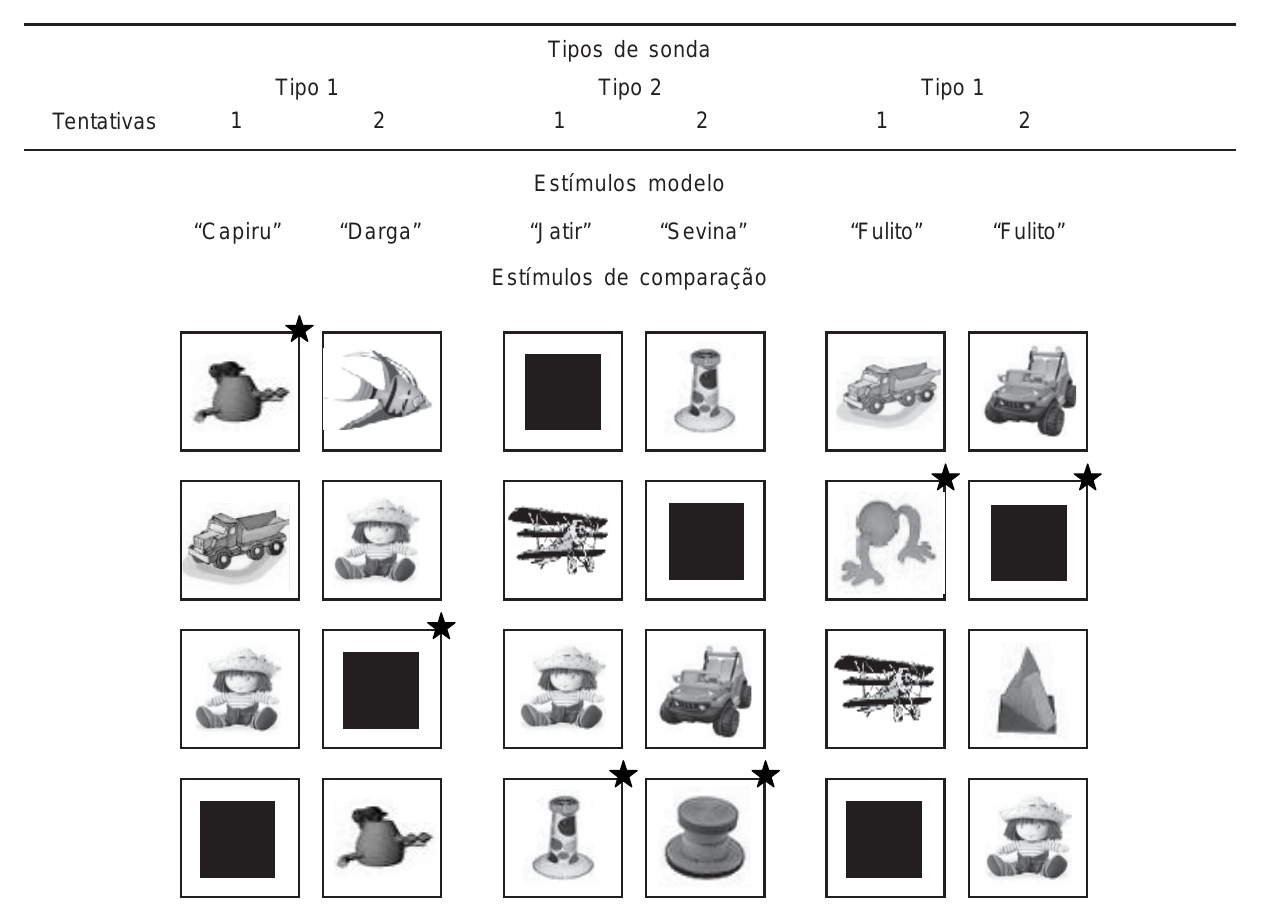
Figura 1. Características dos três tipos de sonda: estímulos modelo, amostra de estímulos de comparação empregados em cada sonda e respostas indicativas de exclusão na primeira tentativa e de aprendizagem na segunda tentativa. Em cada tentativa o arranjo de estímulos de comparação incluía e quatro ou cinco estímulos, entre os quais um ou dois